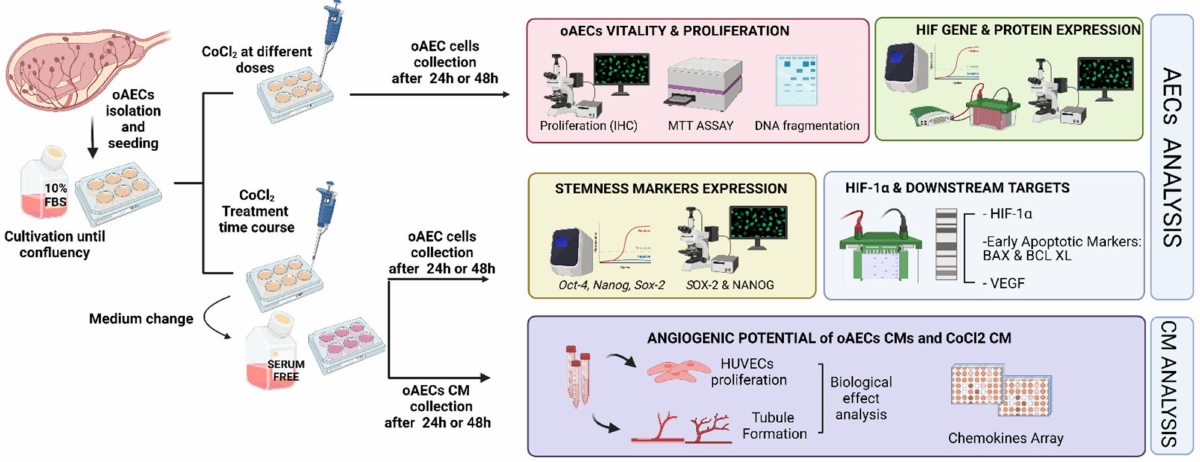
Figure 1. Experimental design. After oAECs isolation and culture until confluency, cells were treated or not with different CoCl 2 concentrations for 24 and 48 h. Analysis on cell vitality and proliferation was firstly conducted to identify the optimal dose for further investigations. Then, in cells treated with CoCl 2 concentrations at various time points, gene and protein expression of HIF-1 α and its downstream targets were analysed. Finally, angiogenic assays investigations were performed on collected conditioned media